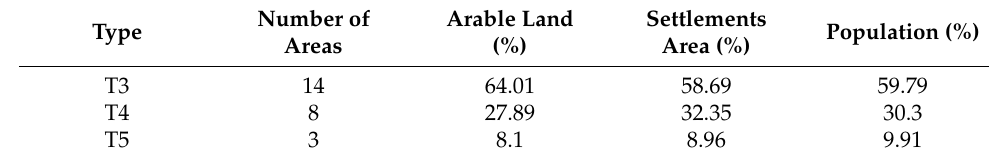
Table 2. Characteristics of decoupling types between rural population and arable land. Table 3. Characteristics of decoupling types between rural population and rural settlements.